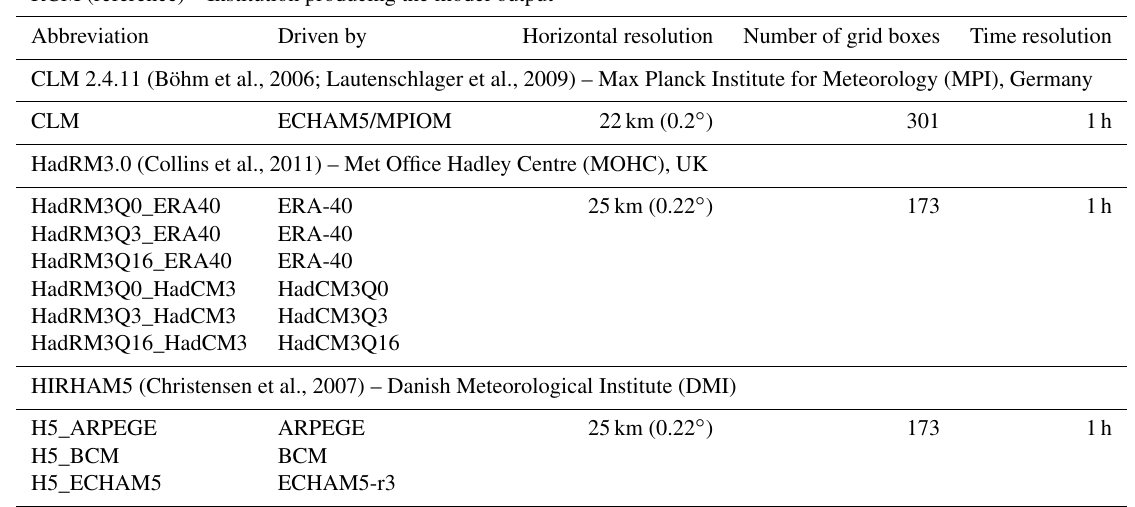
Table 1. RCM simulations analysed. RCM (reference) – Institution producing the model